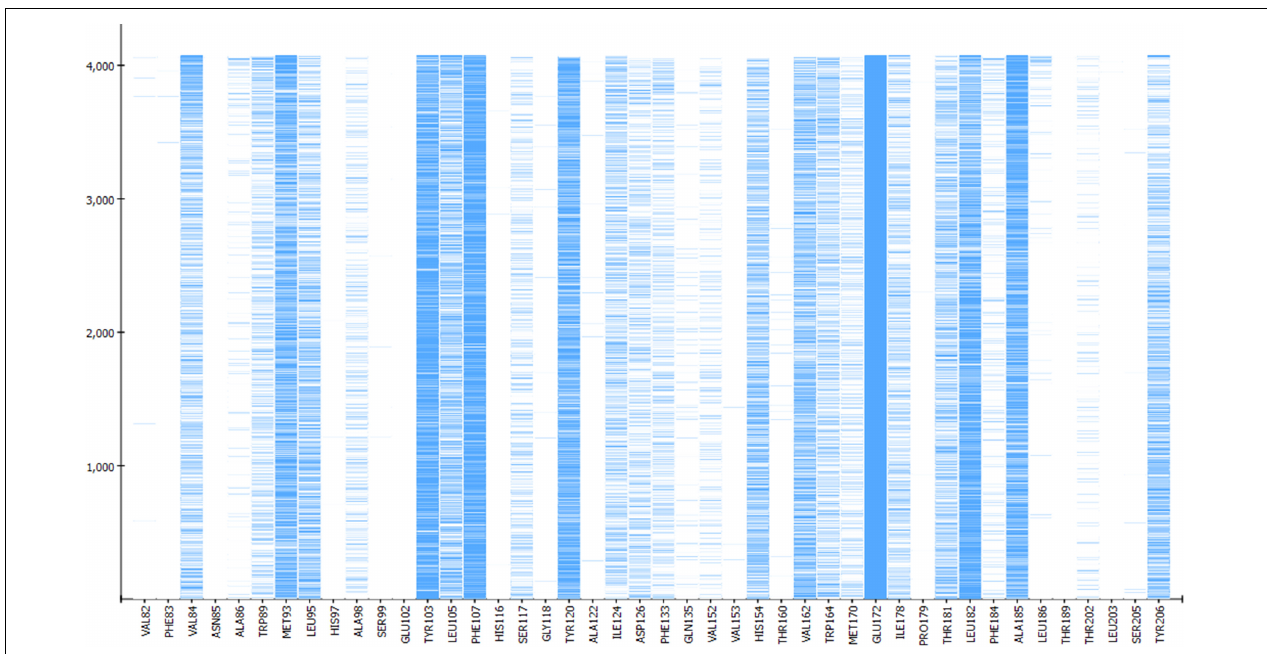
FIGURE 10 | Aminoacids exerting favorable interactions with σ 1R ligands with the best pose scored by –PMF04. Together with Glu172; Met93, Tyr103, Phe107, Tyr120, Leu182, and Ala185 are important for ligand recognition.